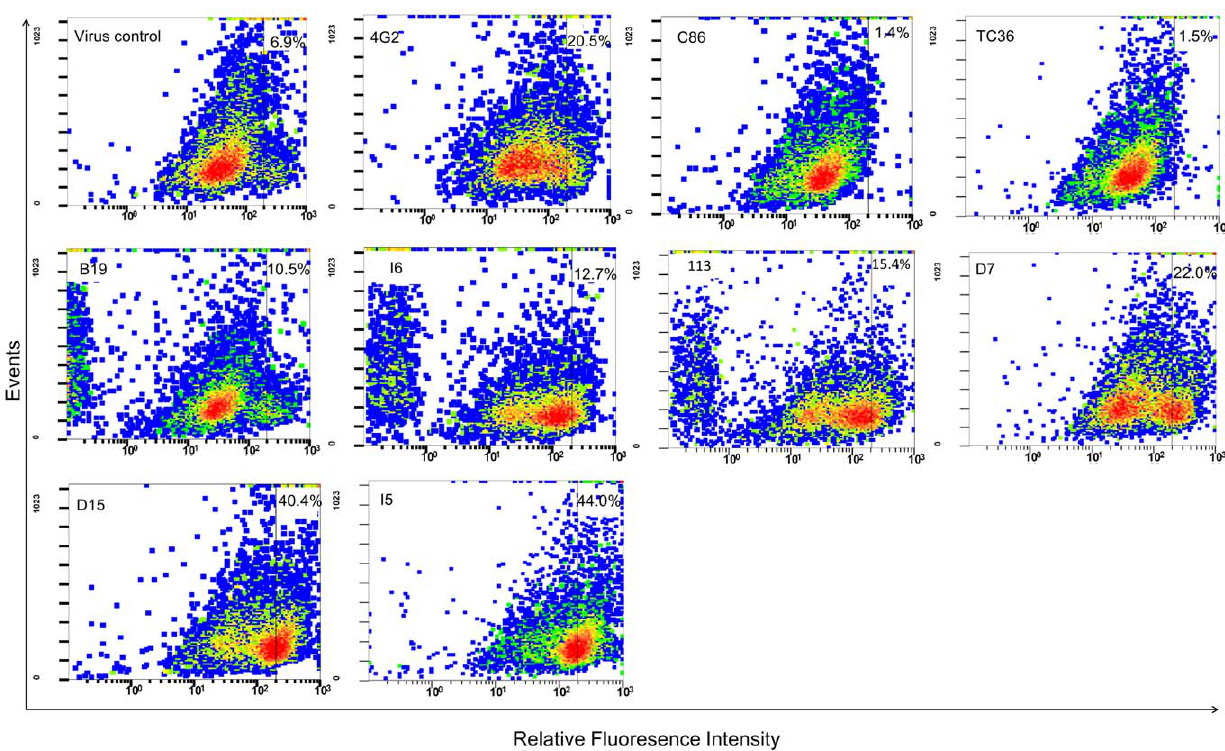
Figure 4. Patterns of ADE in K562 cells infected by virus treated with serum samples. The virus control is GI TC2009-1 virus-infected K562 cells in the absence of serum samples. The ADE of TC2009-1 virus in K562 cells by using 1:100 diluted 4G2 monoclonal antibody as a positive ADE control and the serum samples collected from vaccinated children including C86, TC36, B19, I6, 113, D7, D15, and I5. The K562 cells were collected, stained with mouse anti-JEV HIAF, and analyzed for infection rate by flow